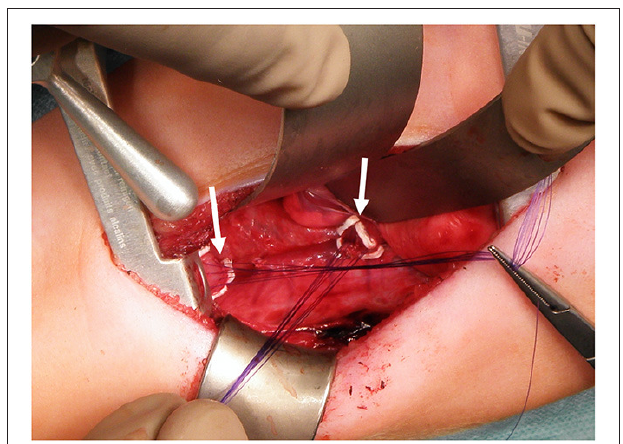
FIGURE 2 | Traction sutures for Foker Procedure. We padded the sutures with PTFE-pledgets (arrows) placed on both esophageal ends to prevent tissue